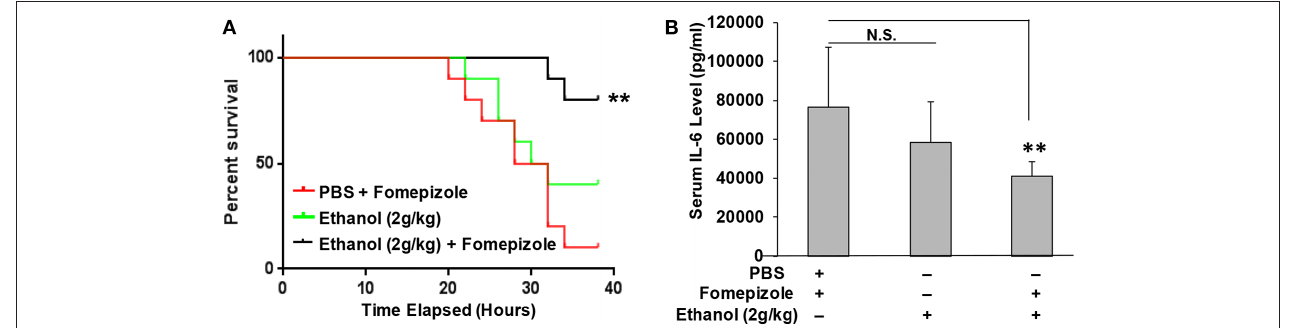
FIGURE 6 | Alcohol dehydrogenase inhibitor fomepizole enhances ethanol suppression of host inflammatory response to LPS and reduces LPS septic shock mortality. (A) C57BL/6 mice were i.p. injected with ethanol (2 g/kg) with or without fomepizole (10 mg/kg). One hour later, a lethal dose of LPS (10 mg/kg) was used to challenge the animals. Control mice were injected with PBS and fomepizole. The Kaplan-Meier survival curve for each group of animals was traced, and statistical comparisons were performed by Log-rank test. Asterisks denote significant difference in each comparison ( n = 10 per group, p < 0.01). (B) Serum IL-6 levels of the mice with similar ethanol and LPS applications in the absence or presence of fomepizole. Asterisks denote significant difference in the comparison ( n = 4 per group, p < 0.01). N.S. indicates no